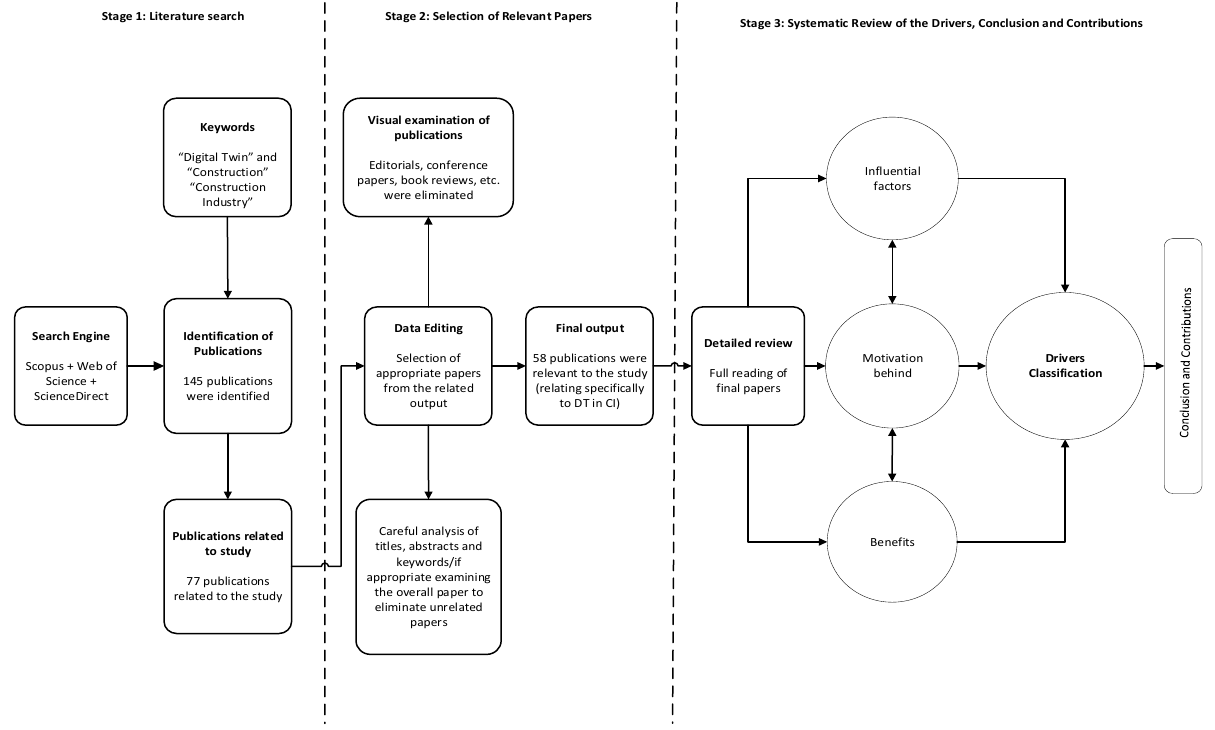
Figure 1. An overview of the literature review and research process adapted from